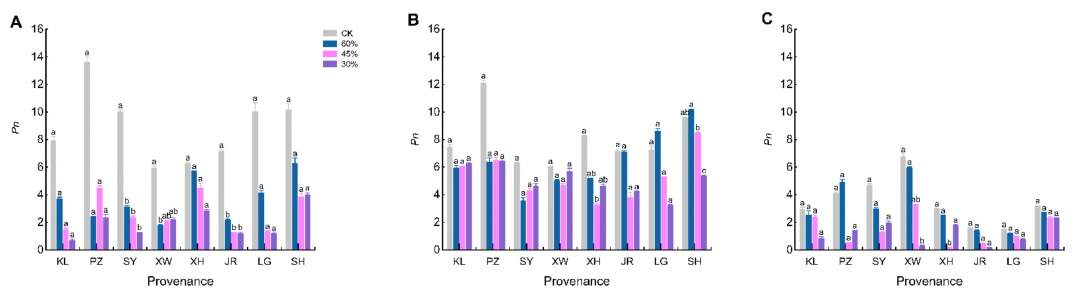
Figure A2. The net photosynthetic rate of Melia azedarach among the different provenances: ( A ): early stage, ( B ): middle stage, and ( C ): late stage. Note: The error line in the figure is the mean ± standard error, and different lowercase letters in the same treatment indicate significant differences at the 0.05 level.